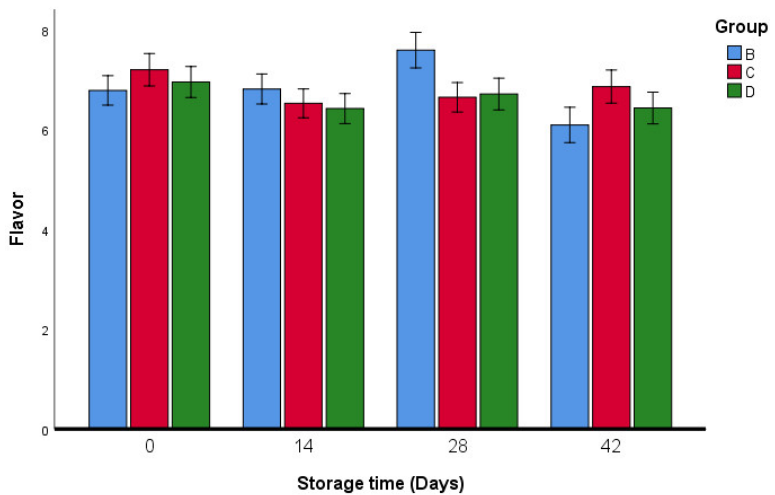
Figure 11. Flavor sensory analysis of fresh oregano during storage period (42 days). Group B: (73.2% Fresh oregano, 15% Fresh Allium cepa , 20% corn oil, 1.8% salt), Group C: (61.9% Fresh oregano, 15% Fresh Allium cepa , 20% corn oil, 1.8% salt, 1.29% sumac “ Rhus coriaria ”), Group D: (59.2% Fresh oregano, 15% Fresh Allium cepa , 20% corn oil, 1.8% salt, 4% lactic Acid, ultimate pH 4.4.